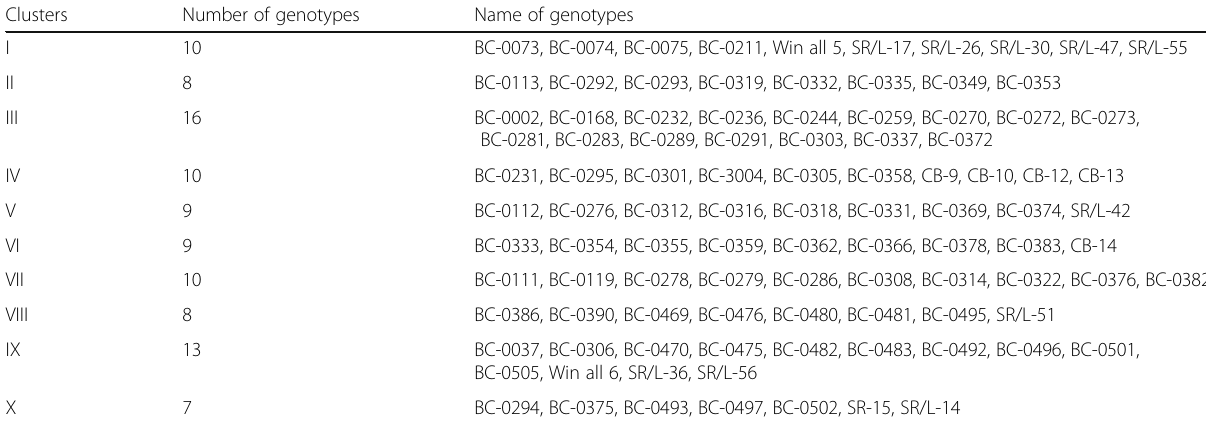
Table 2 Distribution of 100 cotton genotypes into ten clusters Clusters Number of genotypes